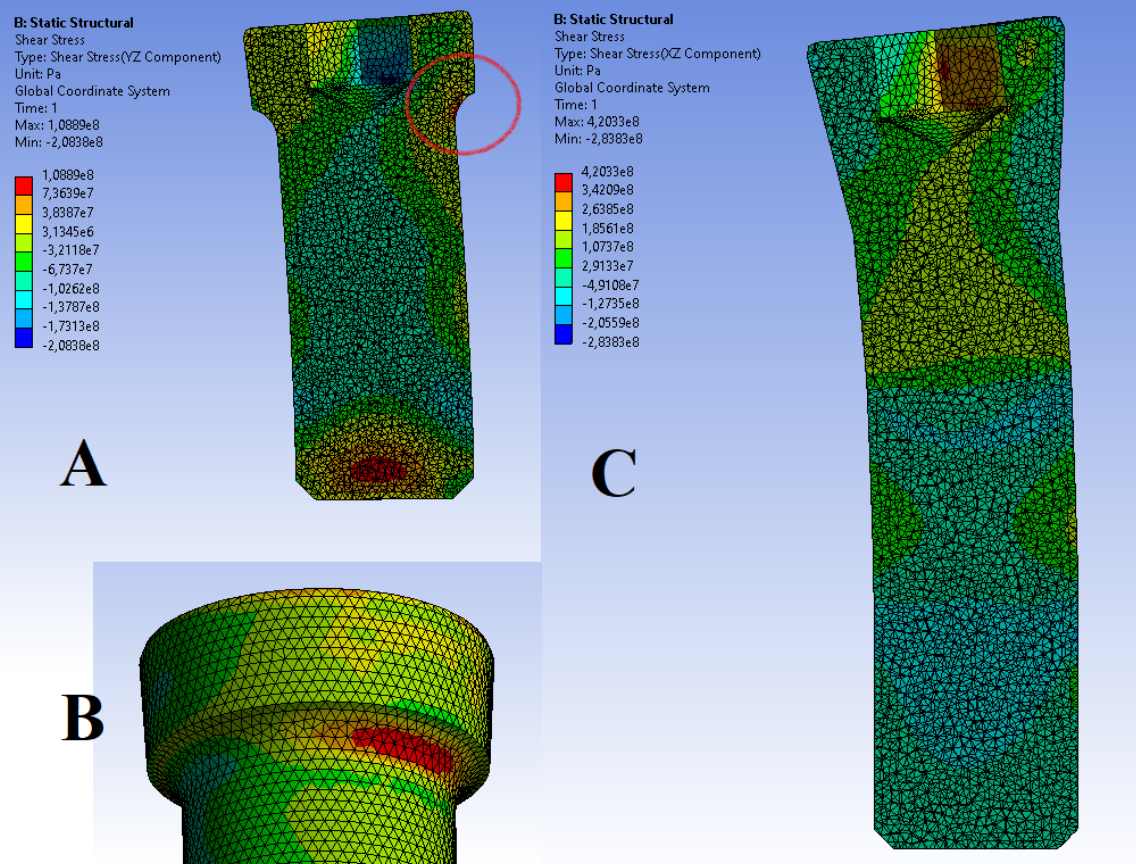
Figure 10. The final results of both analyses (EH and IH variant) of the FEM analyses displayed on the abutment screws. A – section through the abutment screw of the EH variant, typical stress concentration marked red. B – a detail of the area highlighted in "A". C – the new IH geometrical solution with significantly reduced shear stress